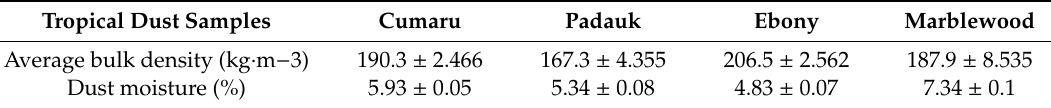
Table 2. Basic physical parameters of samples used in the